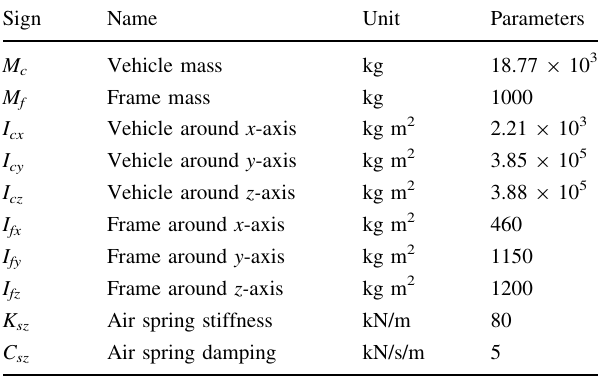
Table 2 Calculation parameters of the Maglev train (30 t